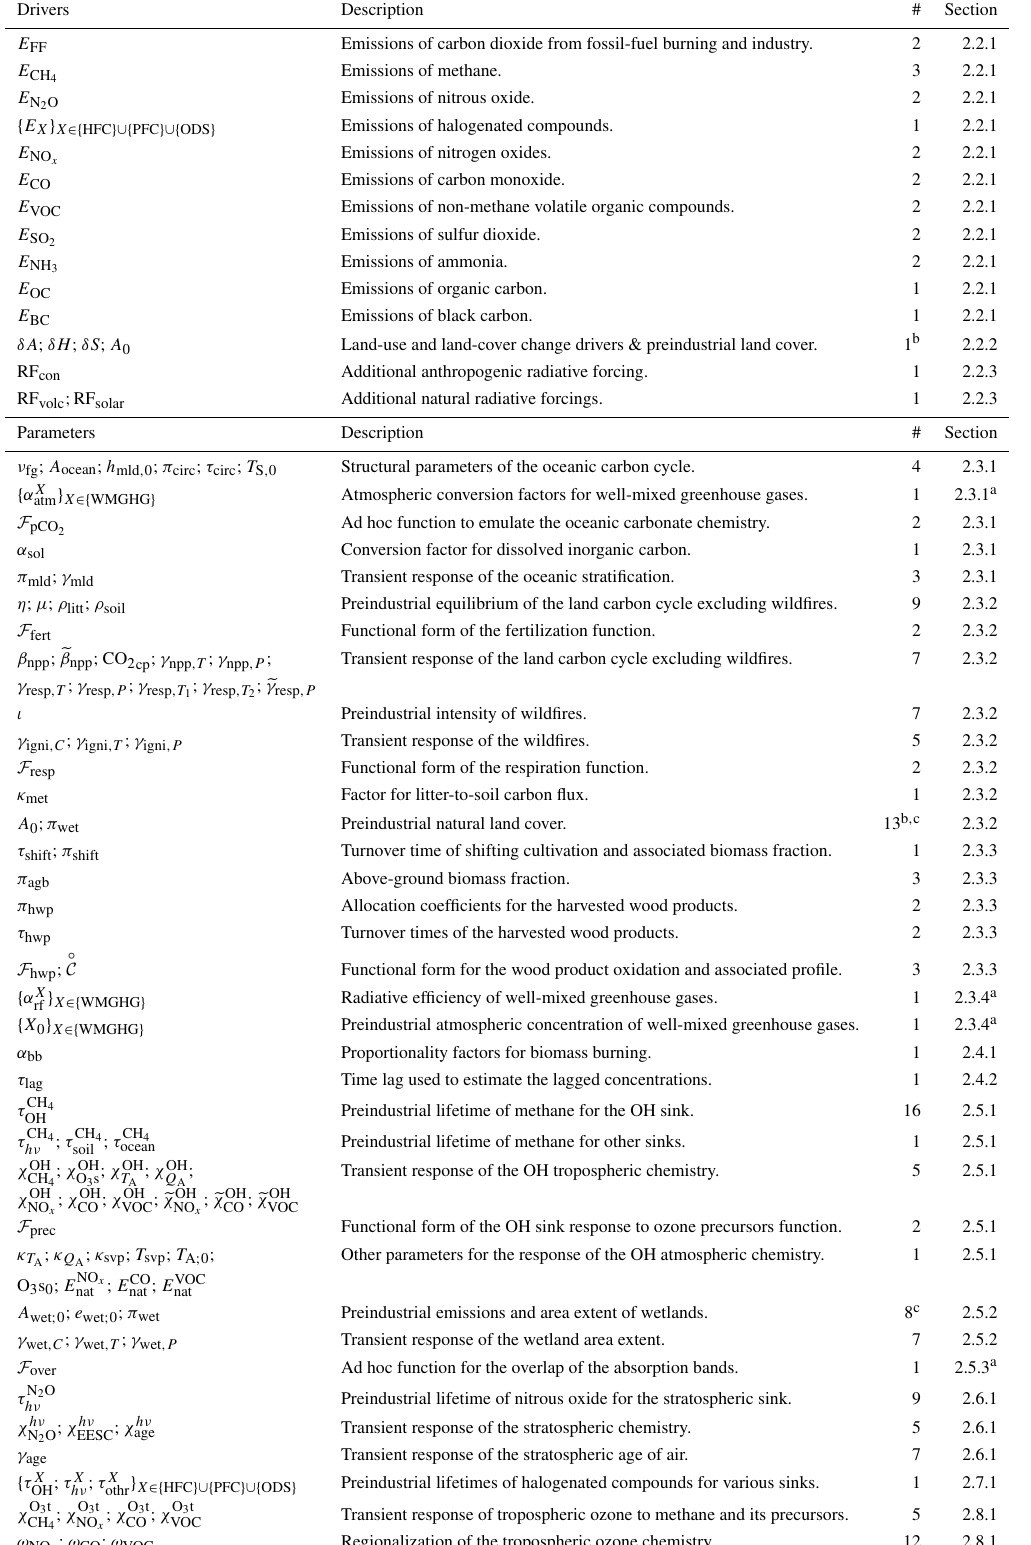
Table 3. List of driving datasets and parameterizations for the probabilistic setup of the model. The “#” column shows how many options are available for the given parameter or set of parameters. Superscripts are omitted for